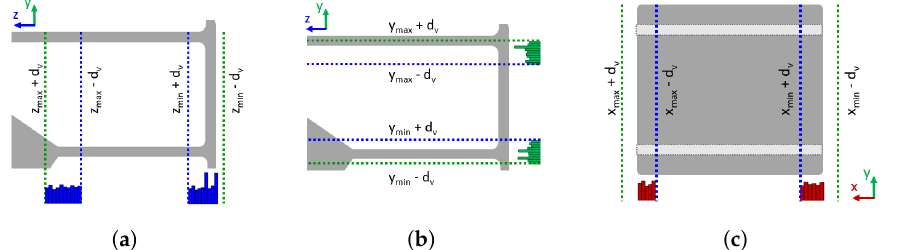
Figure 7. Mesh vertices distribution in storage volume range along: ( a ) z -axis (front view), ( b ) y -axis (front view), ( c ) x -axis (side